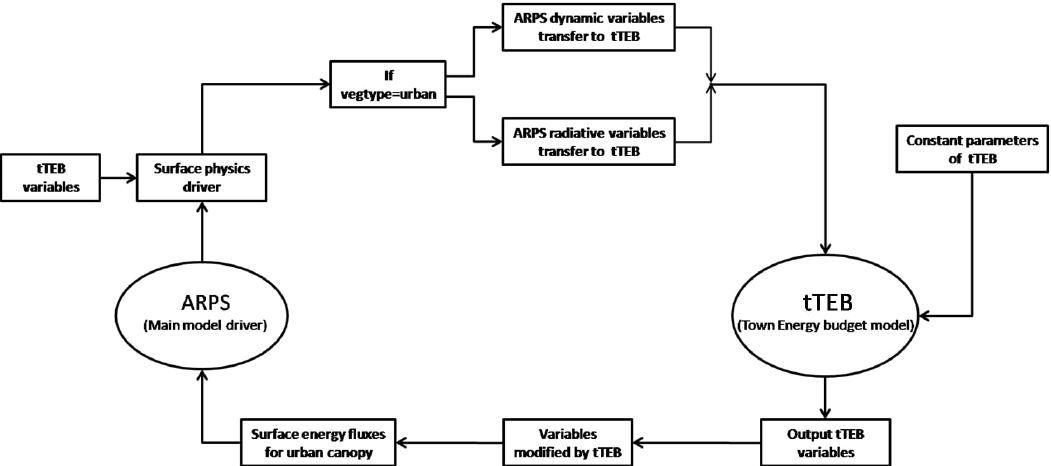
Figure 1. Flow chart indicating the coupling of the advanced regional prediction system (ARPS) model with the tropical town energy budget (tTEB) scheme. The dynamic and radiative variables from the ARPS model are transferred to the tTEB scheme and the output surface variables of the tTEB scheme are returned to the ARPSs